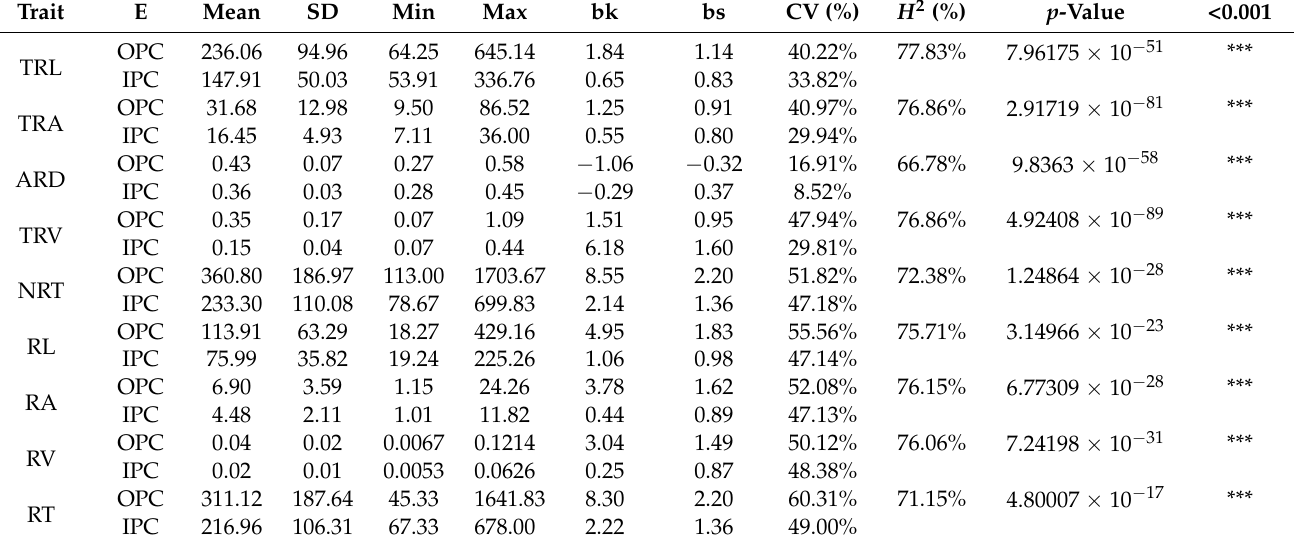
Table 2. Phenotypic analysis of nine RSA traits for this wheat panel under two environments.